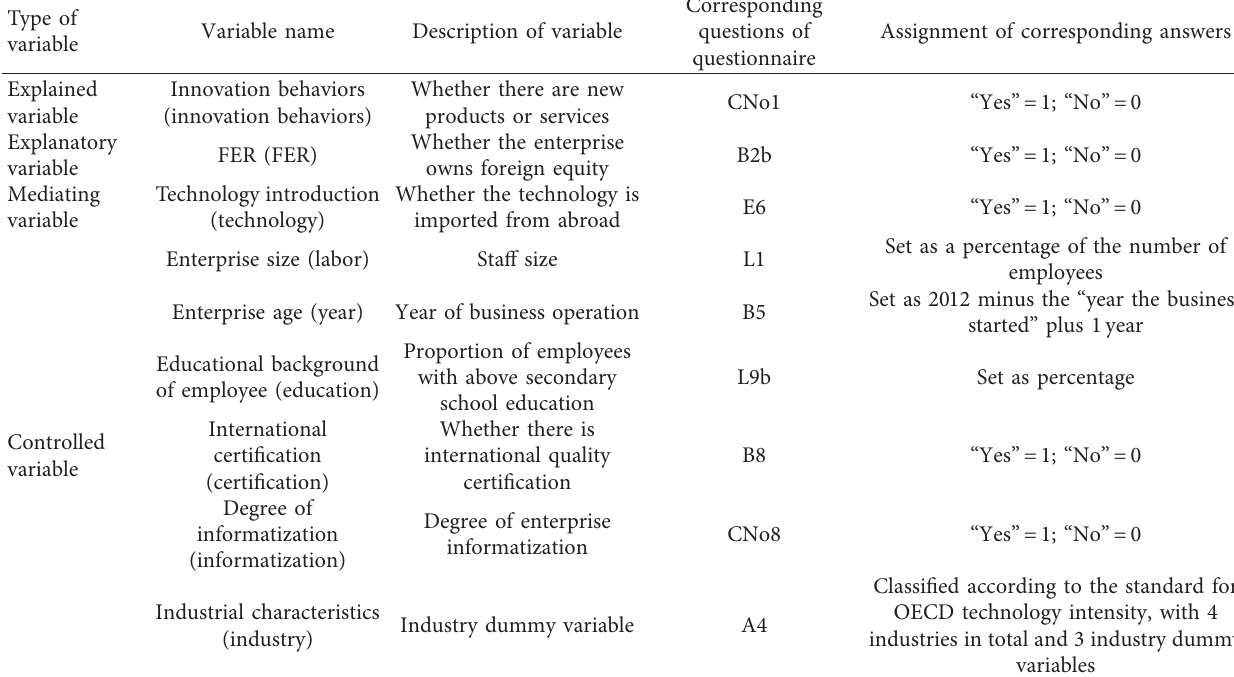
Table 1: Variable